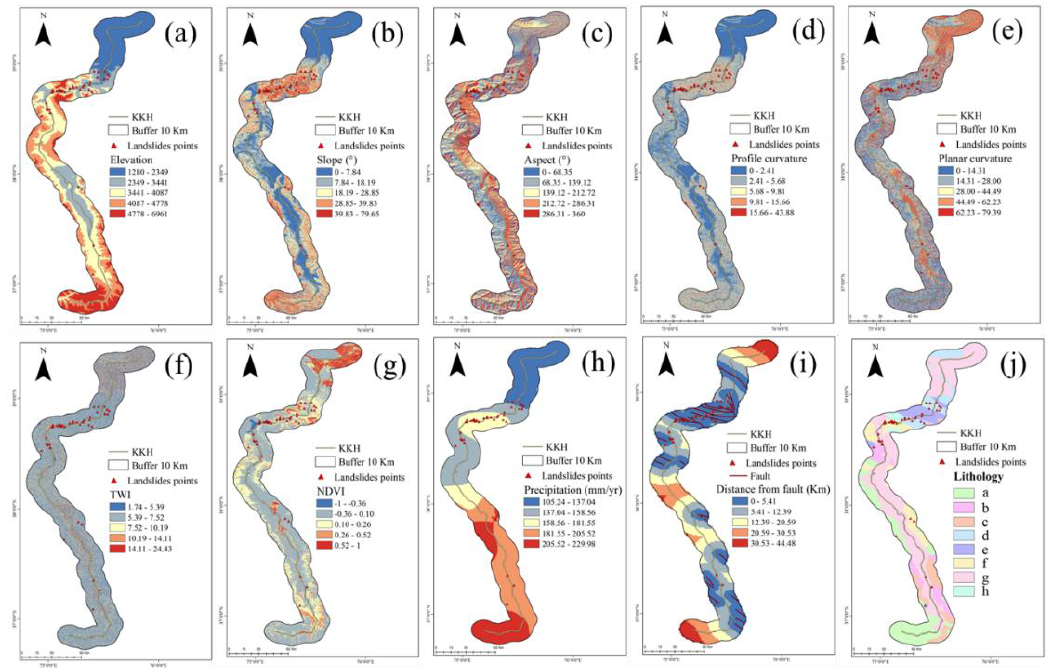
Figure 2. Landslide predisposing factors: ( a ) is the elevation, ( b ) is the slope, ( c ) is the aspect, ( d ) is the profile curvature, ( e ) is the planar curvature, ( f ) is the TWI, ( g ) is the NDVI, ( h ) is the precipitation, ( i ) is the distance from the fault, and ( j ) is the lithology. In (j), a represents plagioclase, monzonite, potassium feldspar granite, diorite, granodiorite, b represents calcareous siltstone, quartz sandstone, phyllite, clastic rock containing pyrite crystals, c is clastic rock sandwiched limestone, occasionally sandwiched siltstone, quartz sandstone, d is gray mudstone, sandstone, black argillaceous siltstone, gray sandy mudstone, limestone, e is gray medium thick, massive limestone, bio-limestone, marl, variegated conglomerate, f is sericite green clay schist, quartz schist marble, quartz marble, dolomite quartz schist, g is gravel, sand, sand soil, gravel soil, sub-clay, and h is snow area.